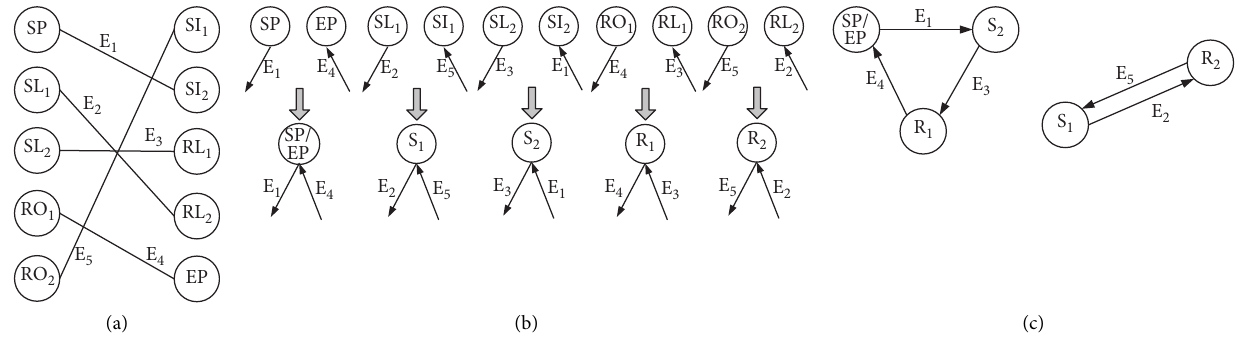
Figure 4: Solution of TSP with subloop relaxation transformed from assignment scheme. (a) Assignment scheme. (b) Node merging. (c) Solution of TSP problem with subloop Figure 5(b), no-load travel E k that connects A ∈ EP , SL , . . . SL , RO , . . . RO , . . . 􏼈 􏼈 􏼉 and B ∈ SP , SI m n 1 1 1 , . . . RL } and no-load travel E SI m , RL n l that connects 1 C ∈ SP , SI , . . . SI , RL , . . . RL , . . . 􏼈 􏼈 􏼉 and D ∈ EP , SL m n 1 1 1